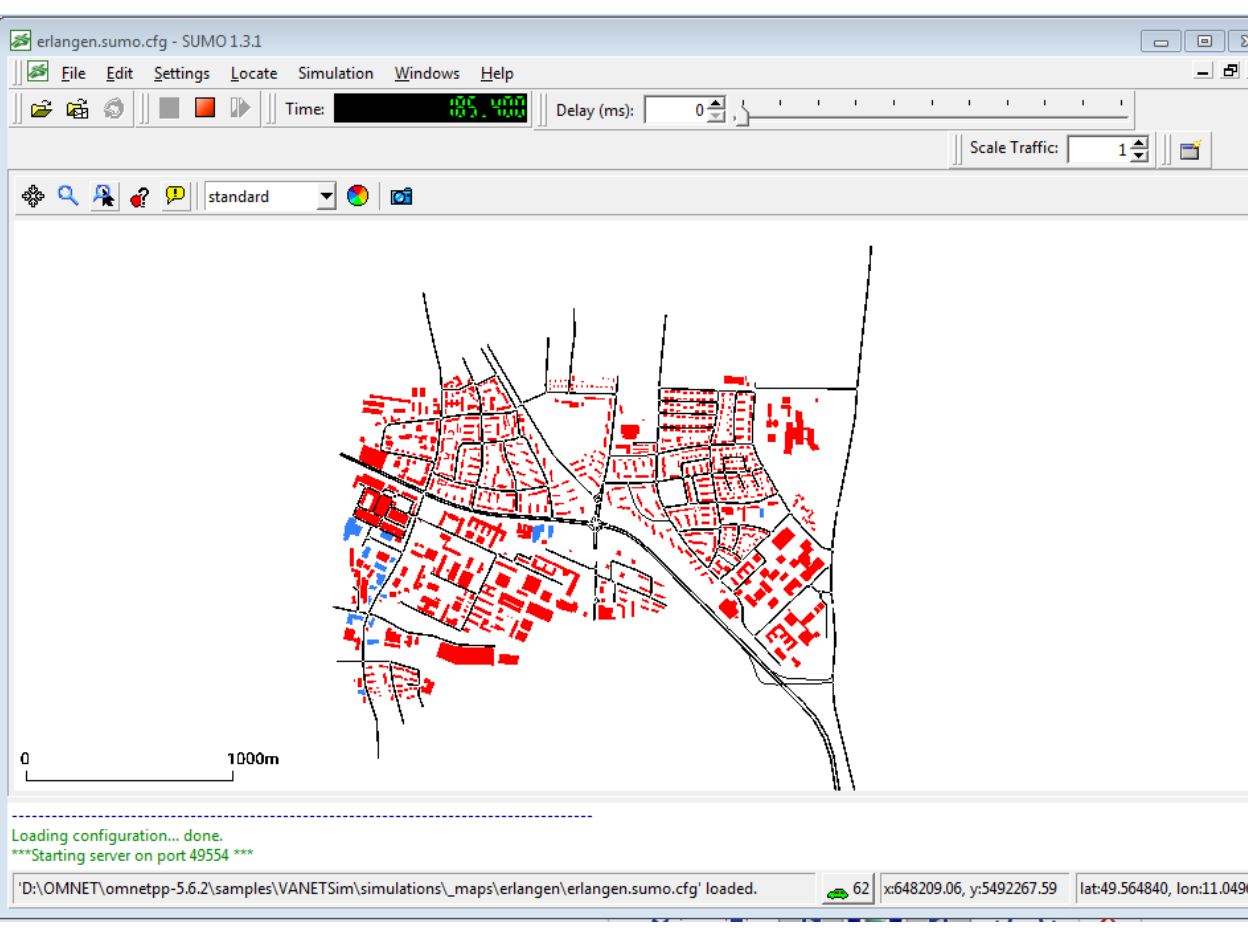
Figure 8. Mobility traffic scenario. Table 4. Simulation